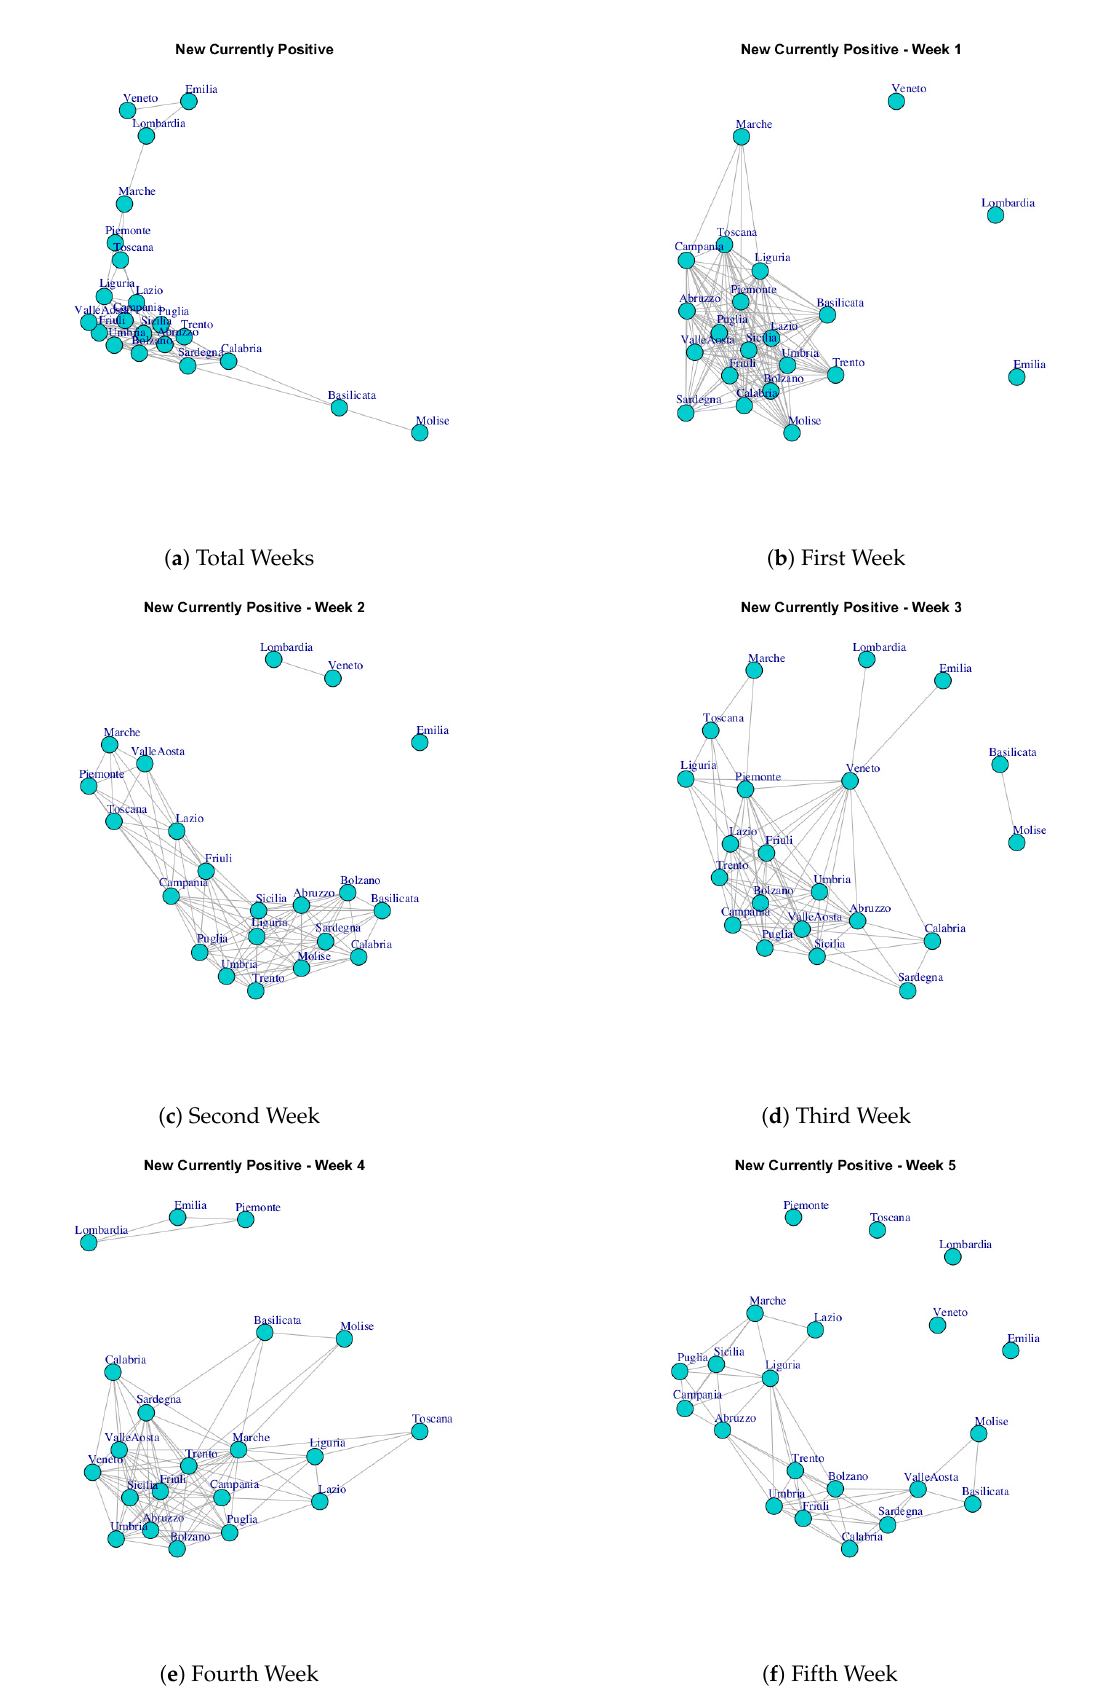
Figure 8. Evolution of New Currently Positive